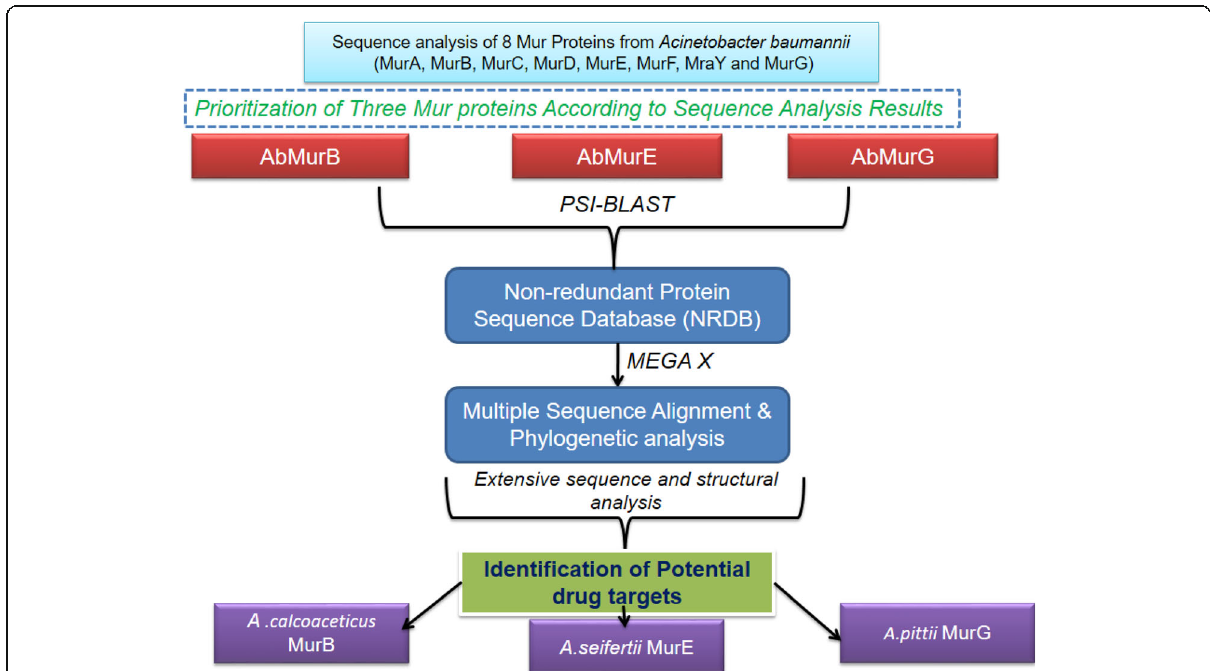
Fig. 18 Overall workflow for the prioritization of Mur family proteins from A . baumannii and identification of their homologous proteins in other